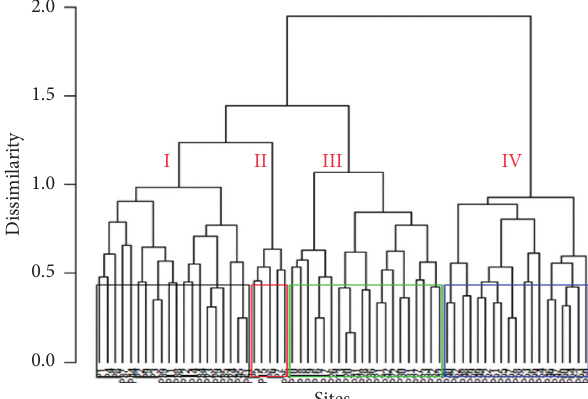
Figure 4: Dendrogram showing the plant community types of Wurg forest.